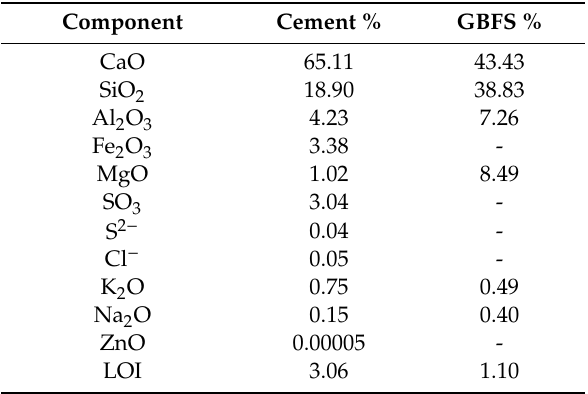
Table 1. Chemical compositions of used components as % by weight.